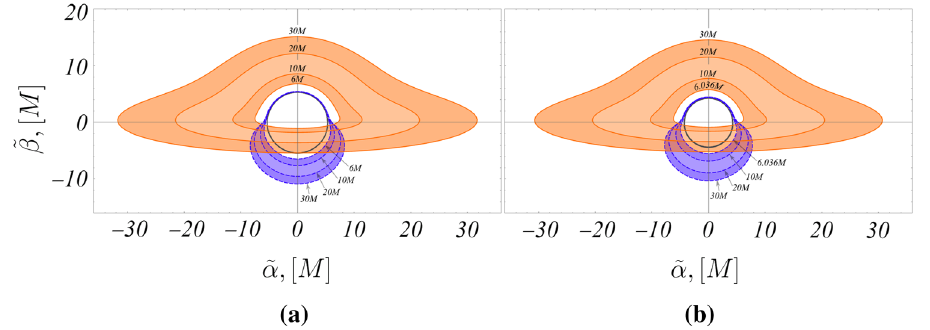
Fig. 6 Optical appearance of a thin accretion disk around the Schwarzschild black hole (left) and the weakly naked Janis–Newman– Winicour singularity (right) with solution parameter γ = 0 . 51. The